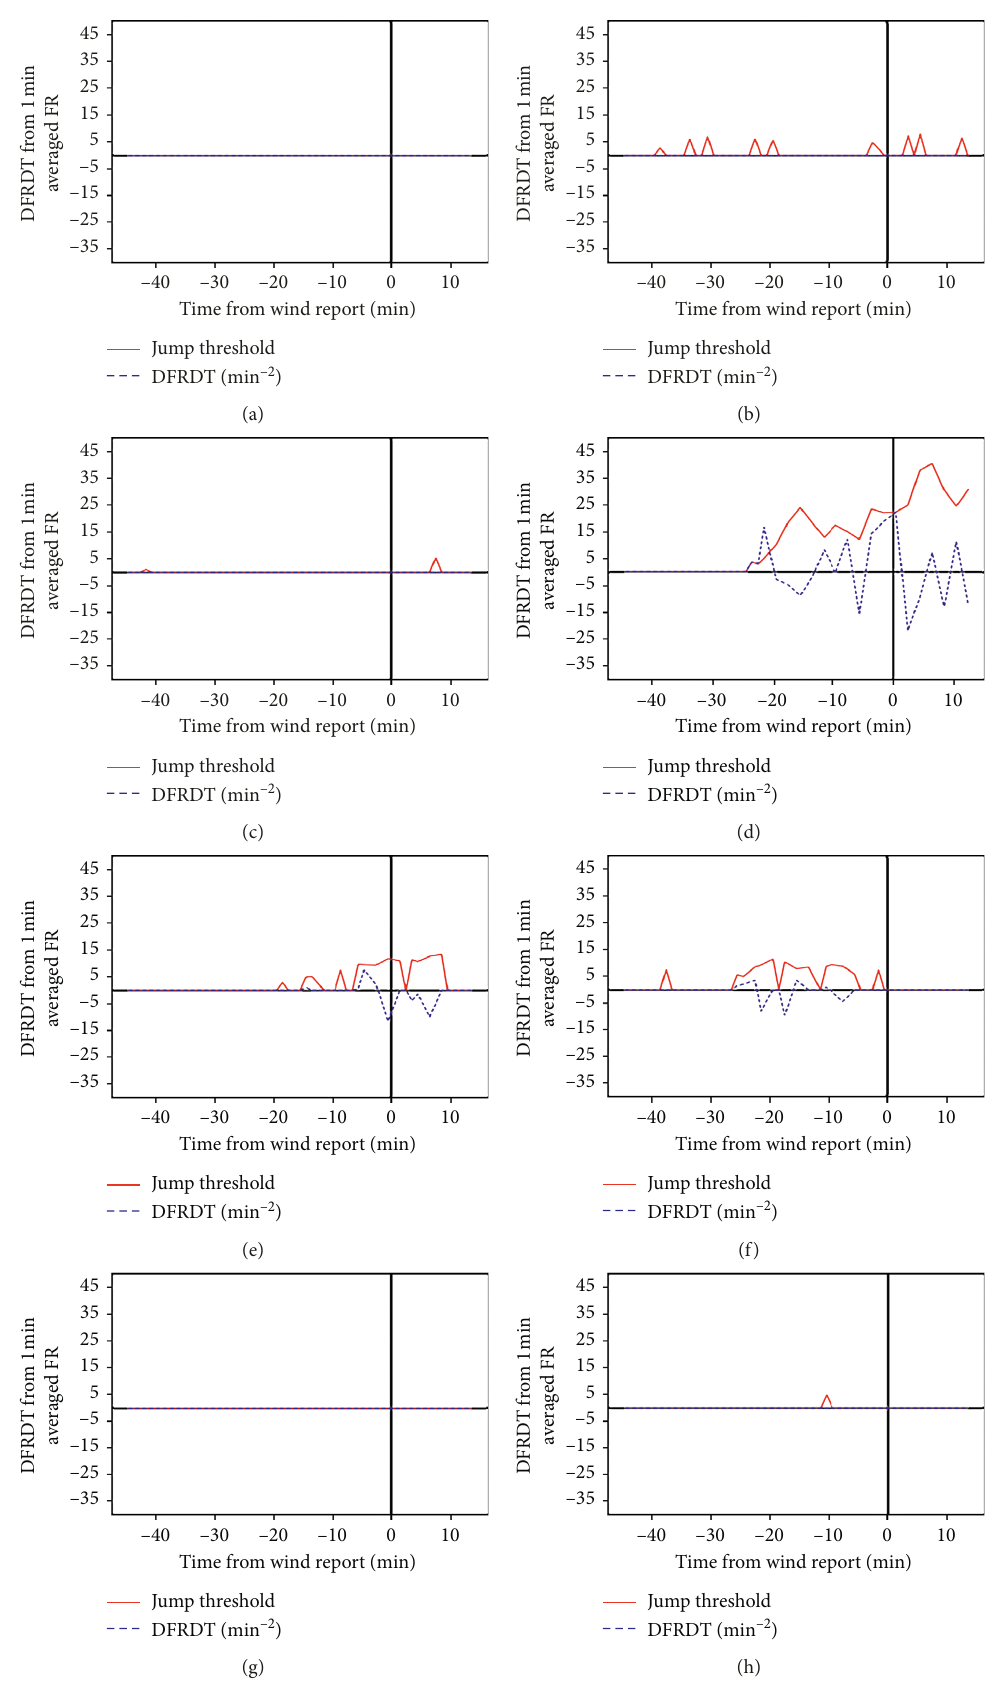
Figure 8: Plots of total lightning using the Schultz et al. [25] 2 σ analysis for the eight null cases. (a) 20120724 total lightning. (b) 20130624 total lightning. (c) 20140703 total lightning. (d) 20150612 total lightning. (e) 20150623 total lightning. (f) 20150630 total lightning. (g) 20150803 total lightning. (h) 20160701 total